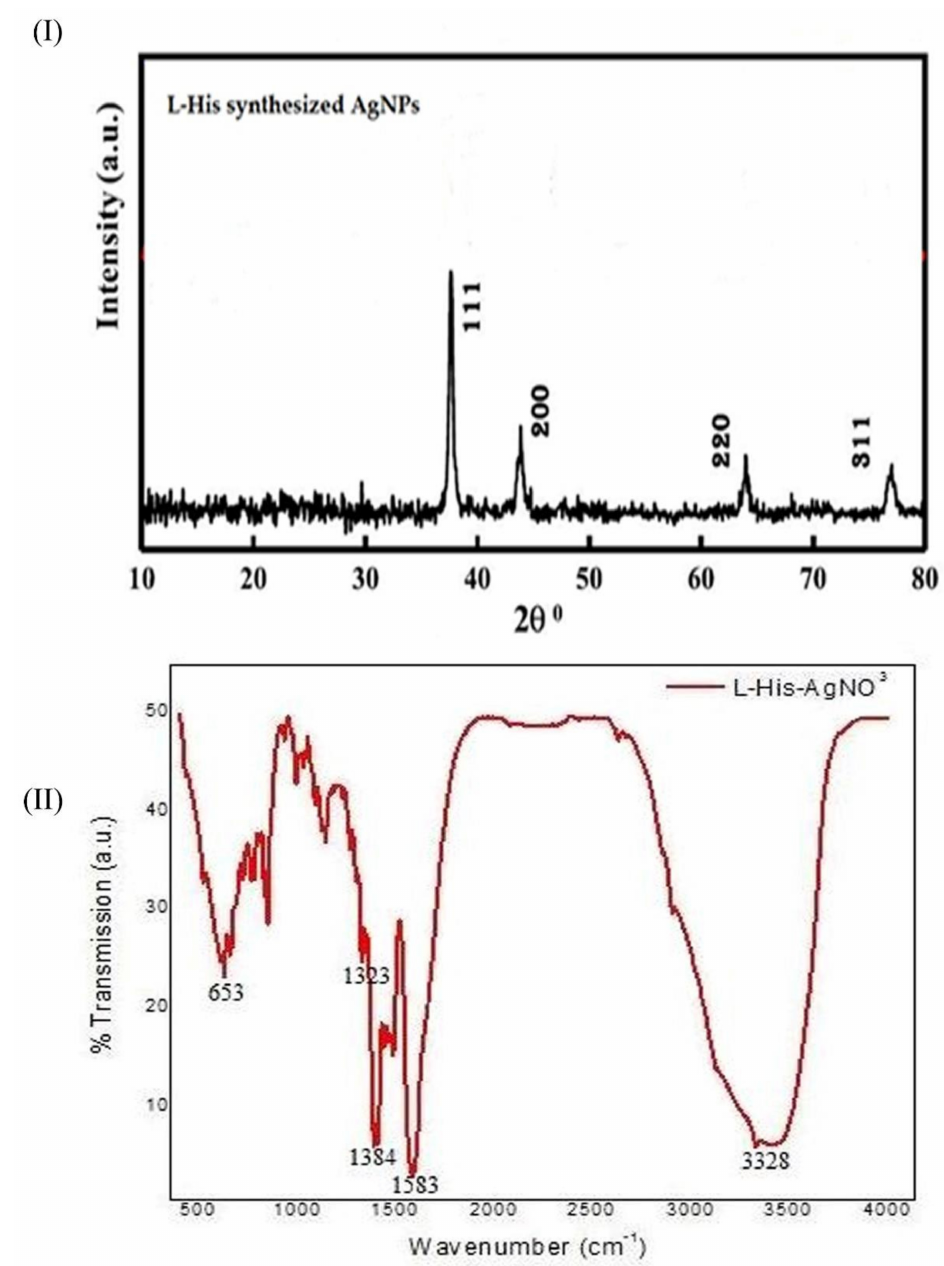
Figure 3. ( I ) X-ray diffraction pattern of L-HAgNPs; ( II ) Fourier-transform infrared spectra of